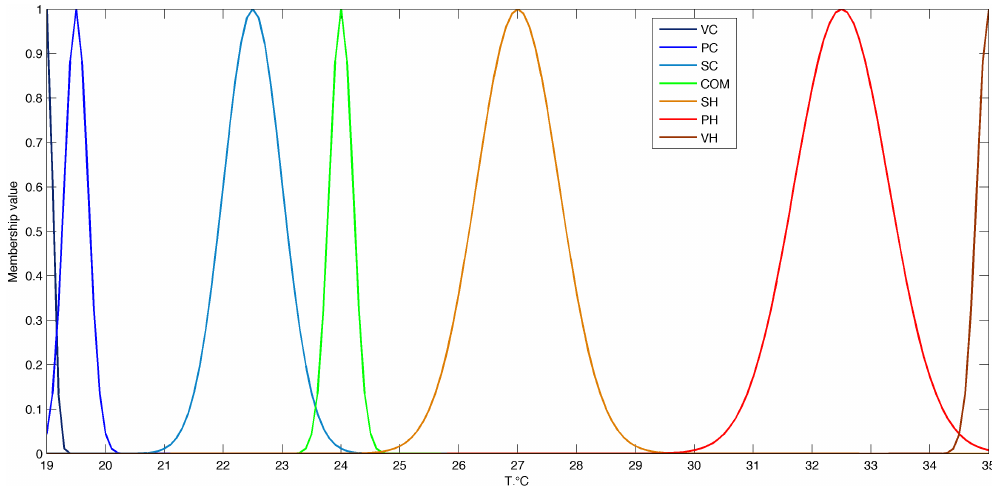
in the summer scenario. i